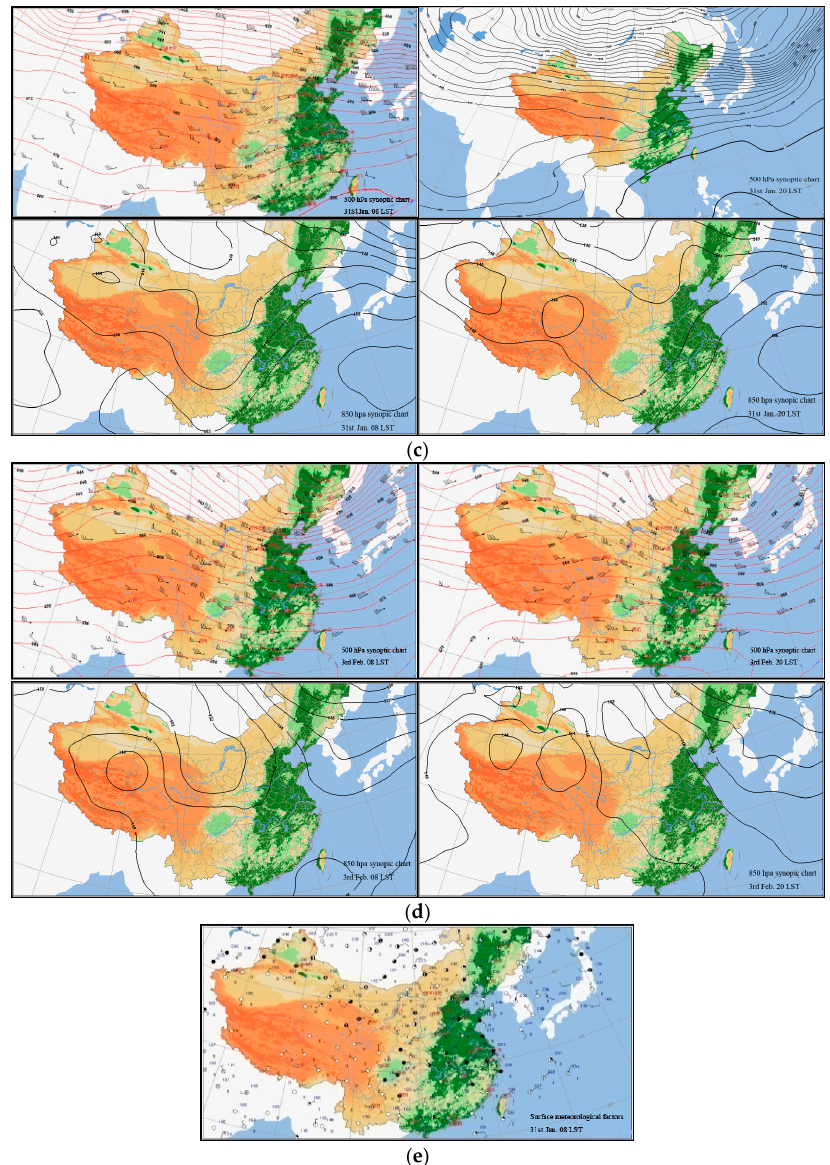
Figure 3. ( a ) 500 hPa and 850 hPa synoptic chart at 08 and 20 LST on the 24th of January; ( b ) 500